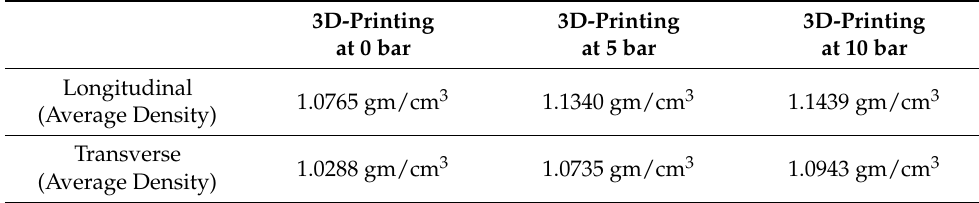
Table 2. Density test results of 3D printed parts in different pressure conditions in Autoclave.